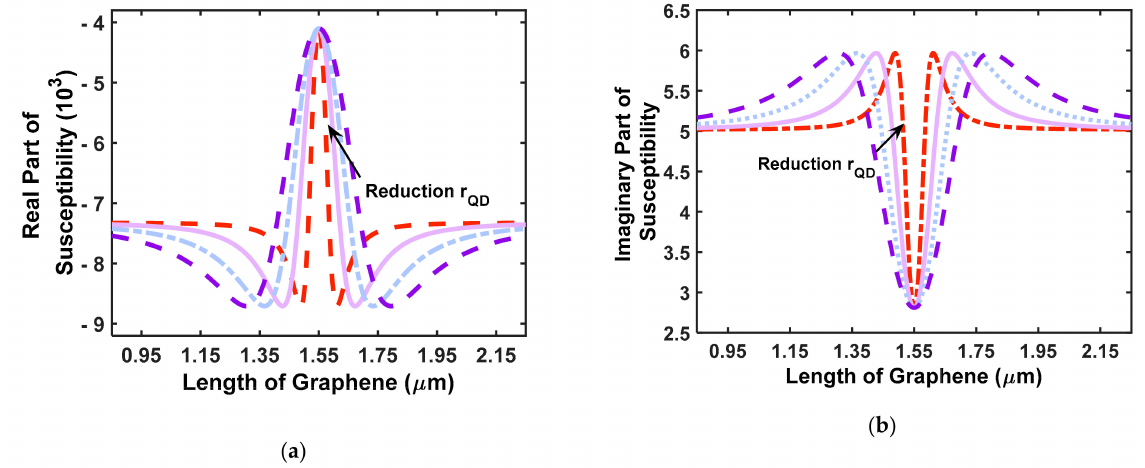
Figure 7. Effect of quantum radius on ( a ) real part and ( b ) imaginary part of the susceptibility = 50,100,150,200 (nm)) . ( r QD